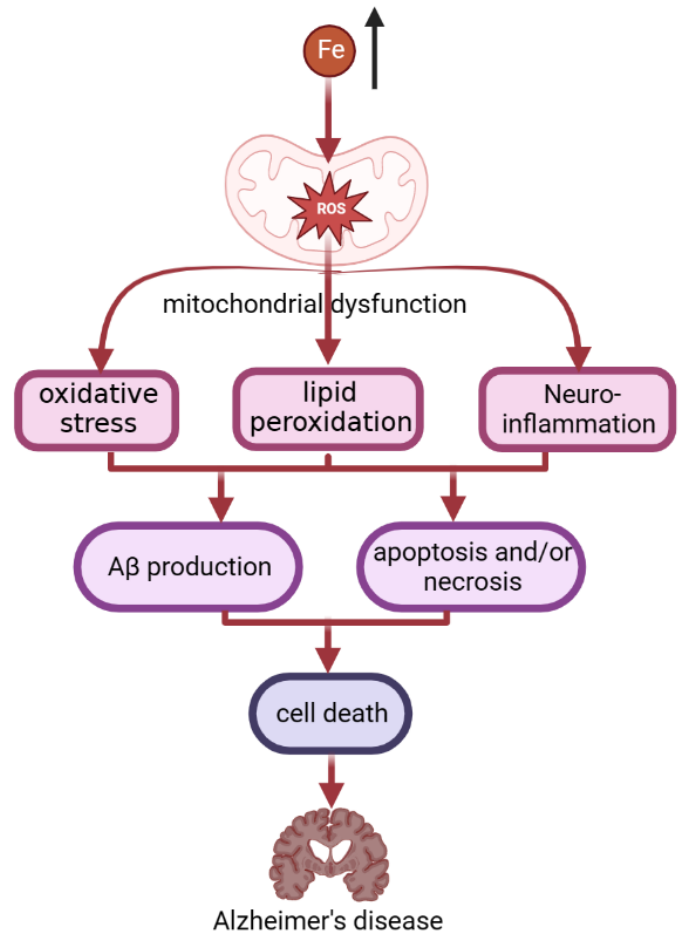
Figure 3. The process of iron accumulation in AD patients. In AD, iron accumulation induces oxidative stress, lipid peroxidation, and inflammatory responses by disrupting mitochondrial function, and inducing ROS production. The combined effects of oxidative stress, lipid peroxidation, and neuroinflammation lead to the production of amyloid-beta (A β ). A β can induce lipid peroxidation in the presence of iron ions. Through these mechanisms, iron accumulation induces apoptosis and/or necrosis, thus leading to cell death. This finally leads to becoming an AD patient.